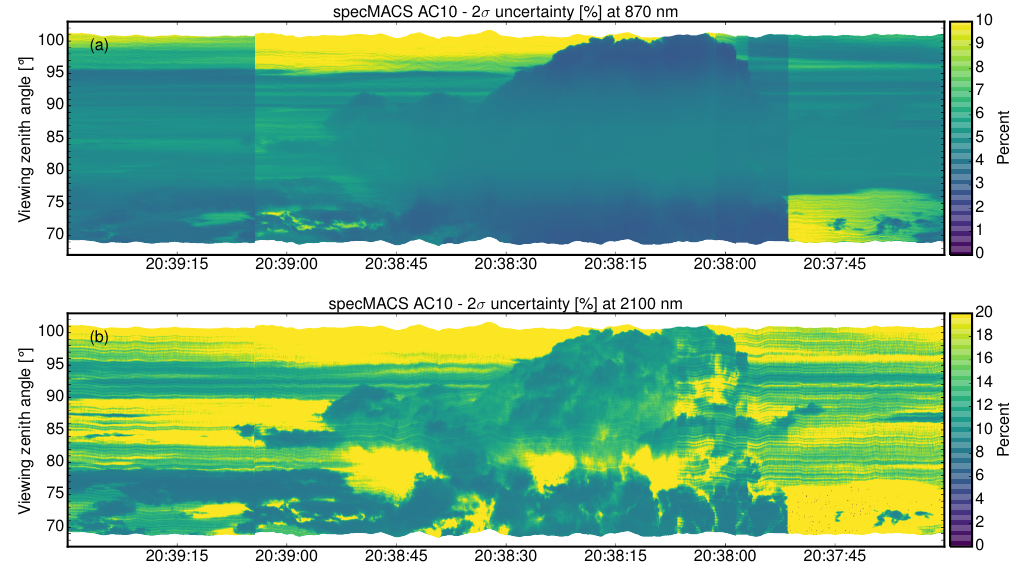
Figure 24. Relative uncertainties (2 σ ) in percent for the spectral measurements of cloud sides shown in Fig. 23 (a) at 870nm and (b) at